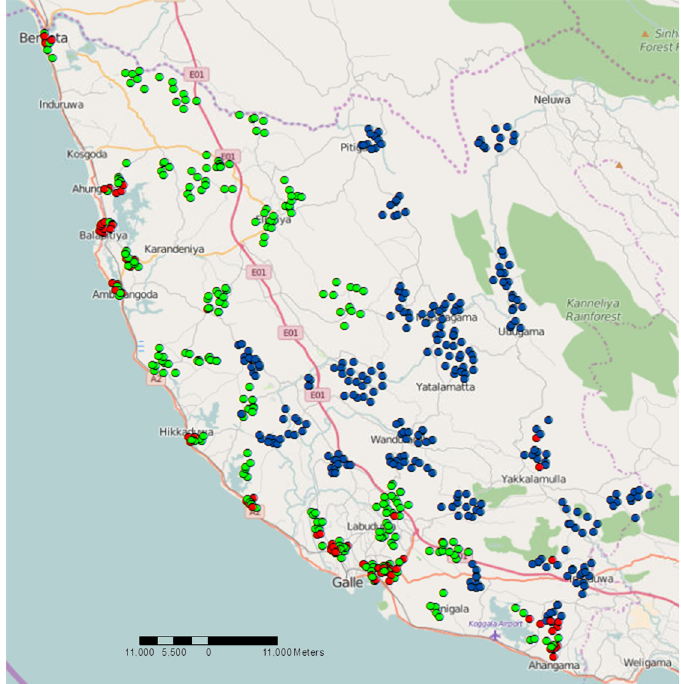
Fig 3. Distribution of mosquito trapping locations tested for filarial DNA in 60 PHM areas in Galle district. Molecular xenomonitoring results show trap locations with no mosquito pools positive for filarial DNA (coastal: green and inland: blue waypoints), and traps with one or more positive pools for filarial DNA are shown in red (in the coastal and inland EU areas).